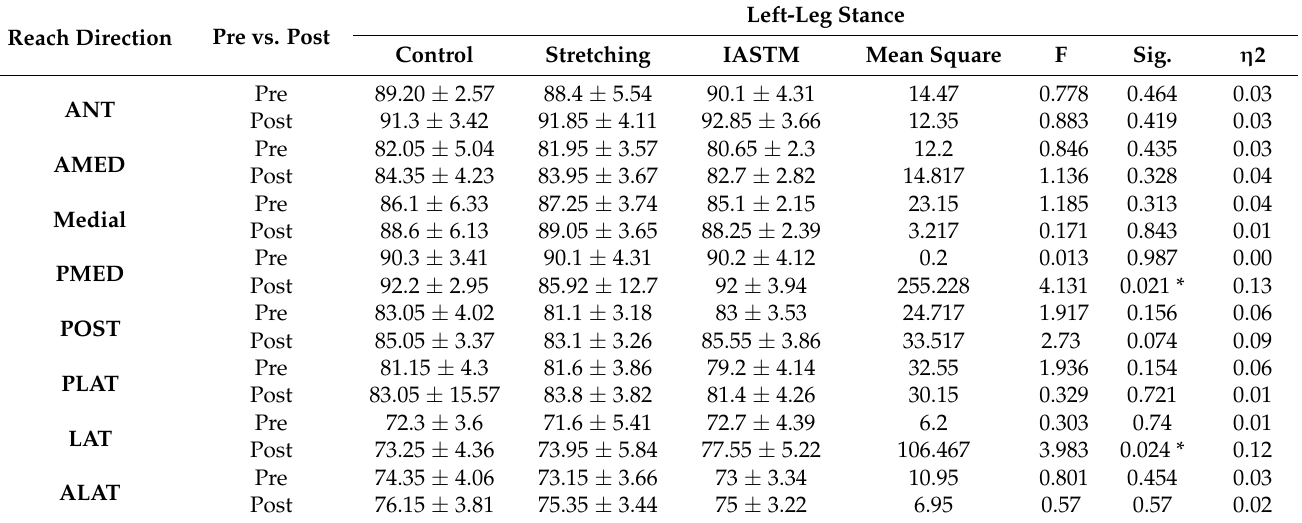
Table 3. Left-leg stance reach distance for star excursion balance test (SEBT) for measuring dy- namic